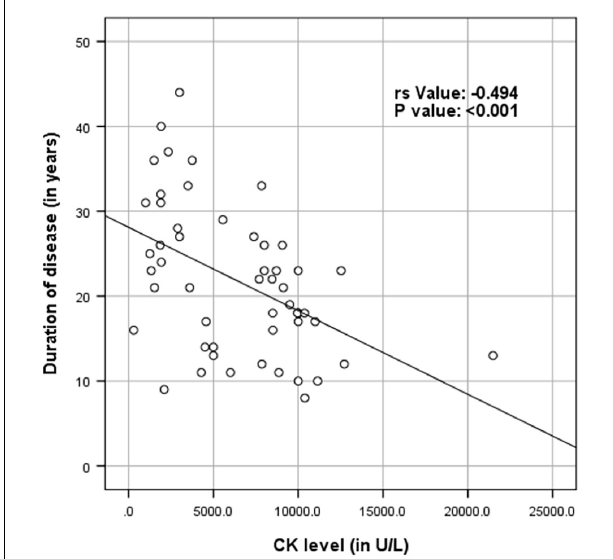
FIGURE 4 | Scatter plot diagram of correlation between duration of disease (in years) and CK levels (in U/L) ( N = 53).